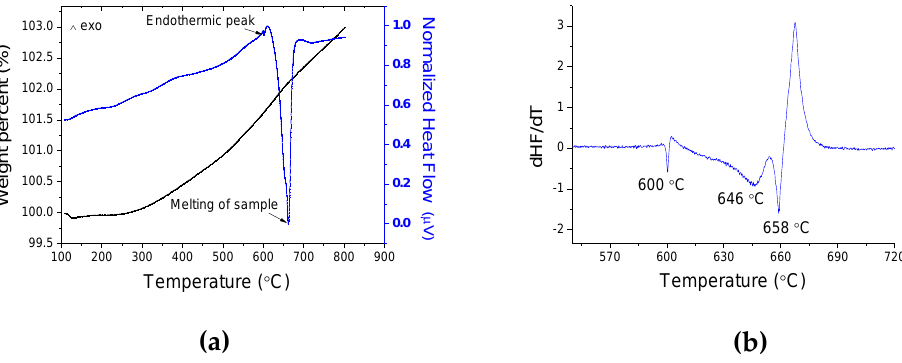
Figure 5. ( a ) Simultaneous thermal analysis (STA) of the as-mixed 2060 powder and ( b ) the first derivatives of differential scanning calorimetry curve (dDSC).